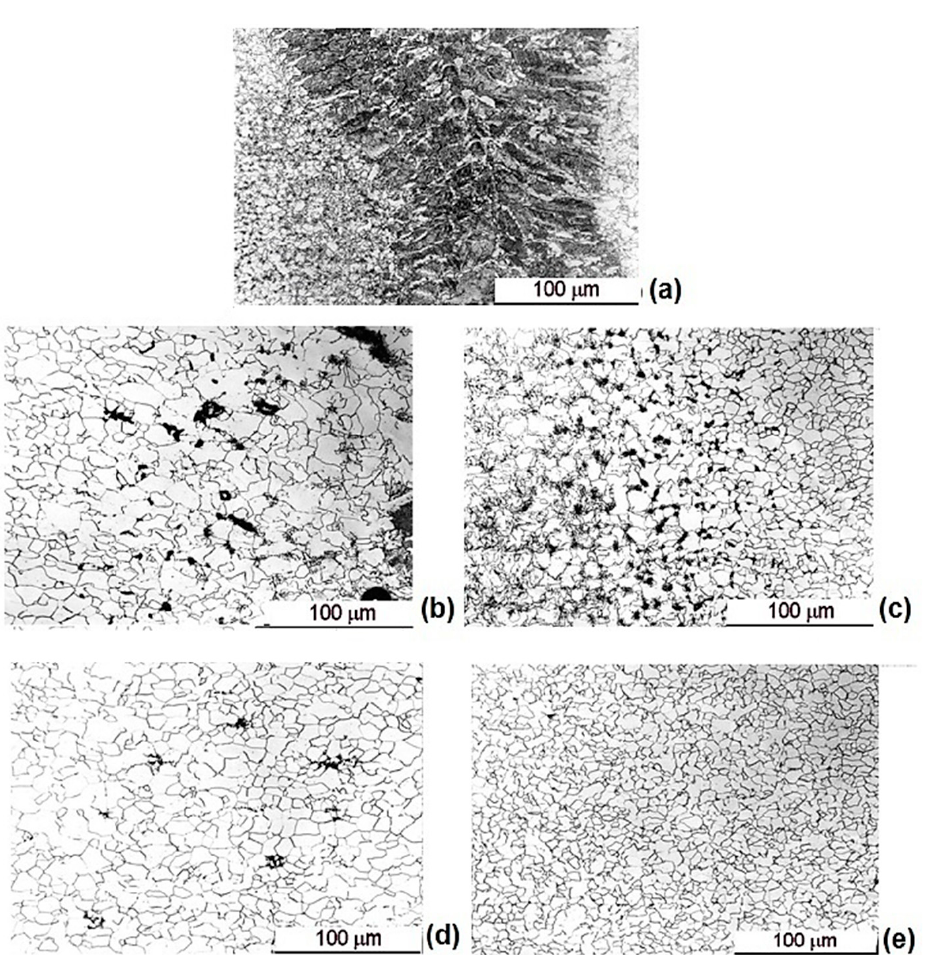
Figure 5. Microstructure of TWB2. ( a ) FZ (DX53D + Z / ZStE260Z); ( b ) HAZ (DX53D + Z); ( c ) HAZ (ZStE260Z); ( d ) BM (DX53D + Z); ( e ) BM (ZStE260Z). Figure 5a FM: Weld metal; the bainitic-ferritic microstructure with acicular ferrite. Figure 5b HAZ: DX53D; the ferritic-pearlite microstructure in the area of high temperature overheating of the base material with a singularly precipitated bainite; in the A C1 –A C3 temperature range is a ferritic-pearlite microstructure with deformed pearlite and enlarged ferrite grains. Figure 5c HAZ: ZStE260Z; the ferritic-bainitic-pearlitic microstructure in the area of high temperature overheating of the base material; in the A C1 –A C3 temperature range is a ferritic-pearlite microstructure with enlarged ferrite grains and deformed pearlite. Figure 5d BM: DX53D + Z; the ferritic-pearlite microstructure with polyedric ferrite grains and sporadically precipitated deformed pearlite. Figure 5e BM: ZStE260Z; the ferritic microstructure, cementite is precipitated in ferrite grains. The structure is